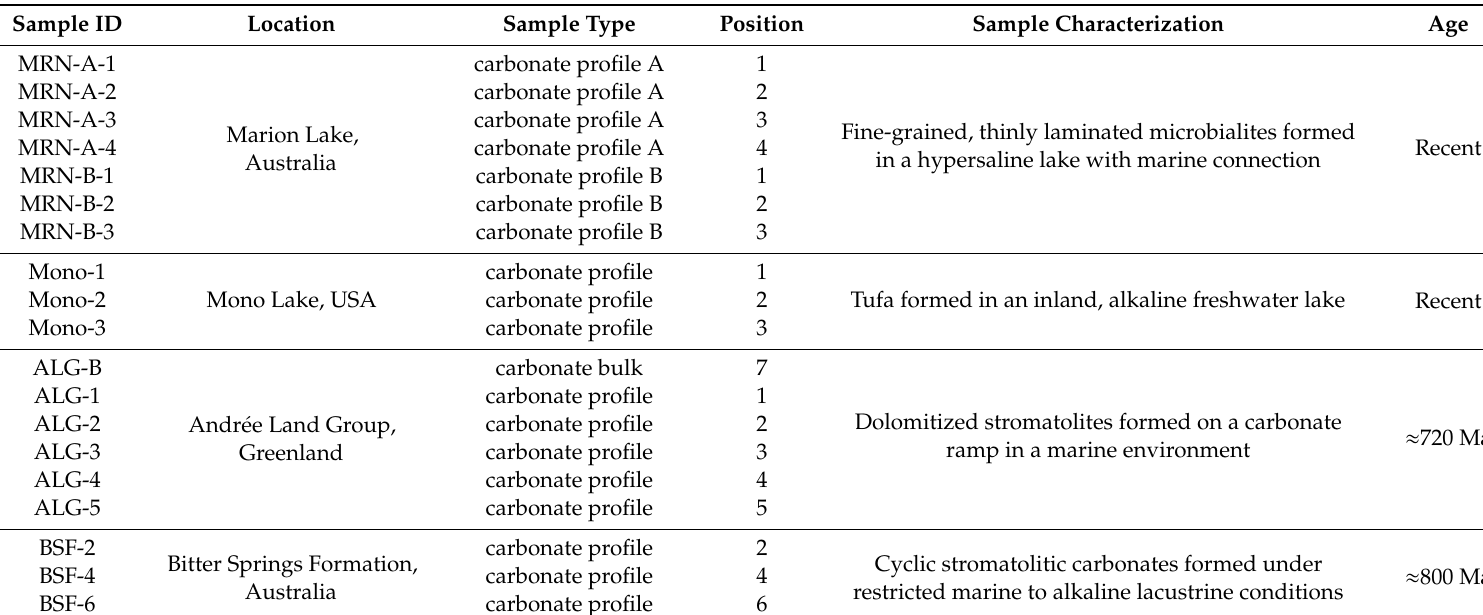
Table 1. Description of microbialite samples. Positions represent inner to outer parts of the microbialite samples (see Figure 1). For water sample sites and geological background, see Figure